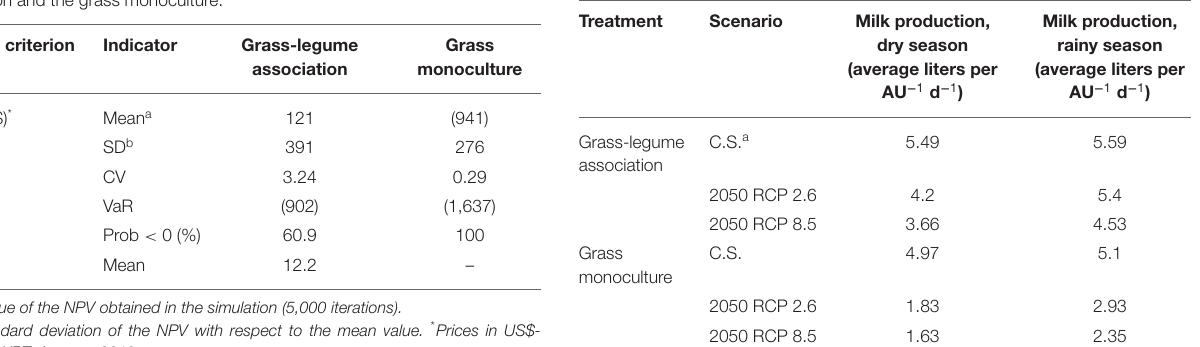
TABLE 7 | Changes in milk production under climate change